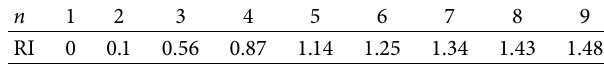
Table 2: Random consensus